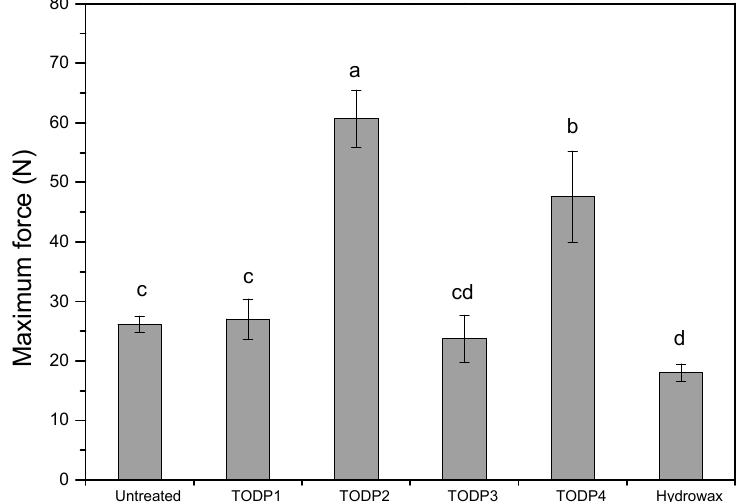
Figure 3. Ultimate tensile strength of paper-sheets treated with TODP-based formulations and hydrowax under dry measuring conditions. Values labeled with a different letter are statistically different (ANOVA and Tukey’s HSD test) at an error probability of α = 0.05. Error bars represent standard deviations.